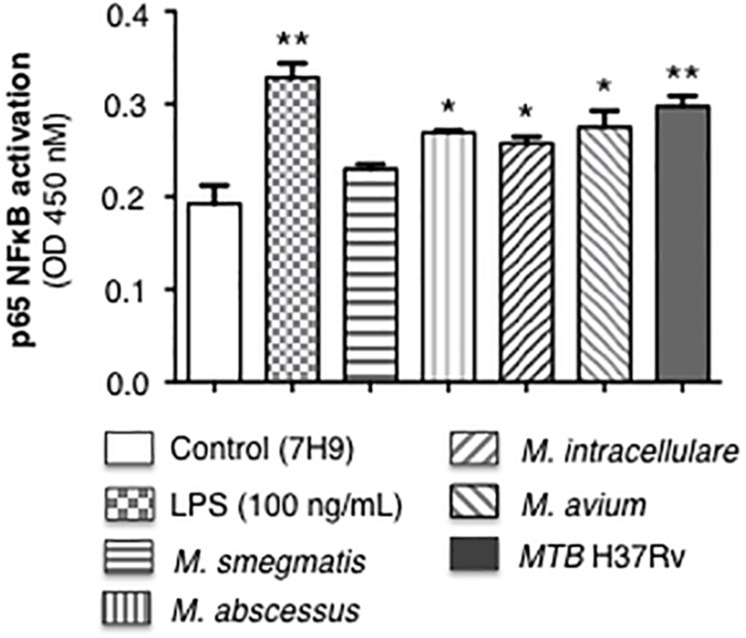
p65-NF-κB activation and binding in response to infection of THP-1 macrophages with different mycobacterial species. THP-1 cells were stimulated with LPS (positive control) or infected with the mycobacterial species at a multiplicity-of-infection (MOI) of 10 mycobacteria:1 macrophage for 6 h, nuclear extracts prepared, and p65-NF-κB binding to its consensus cis-regulatory element was quantified by Active Motif TransAMTM Flexi. Data shown are mean ± SEM of three independent experiments. *p < 0.05, **p < 0.01 compared to uninfected control cells, to which a small volume of 7H9 medium was added, equal in volume to the stock mycobacteria (grown in 7H9 medium) used to inoculate the THP-1 cells.